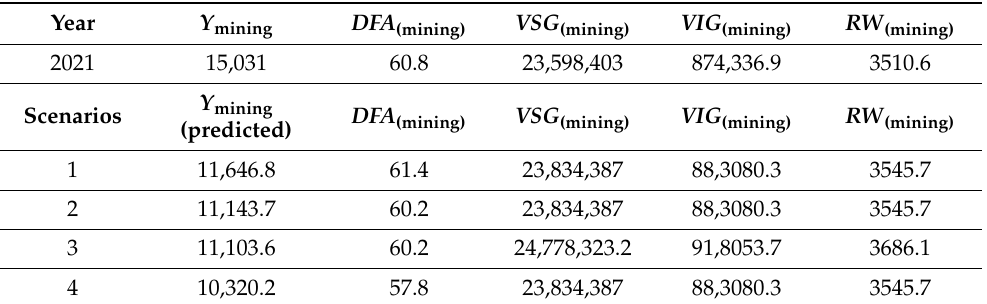
Table 8. Scenarios of changes in the efficiency of industrial systems in the mining sector of the economy.